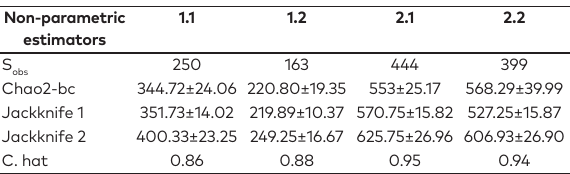
Descriptions of the vegetation types are given below: Cluster 1 : Comprises two vegetation types distributed mainly in the lowlands of the Espinal phytogeographical